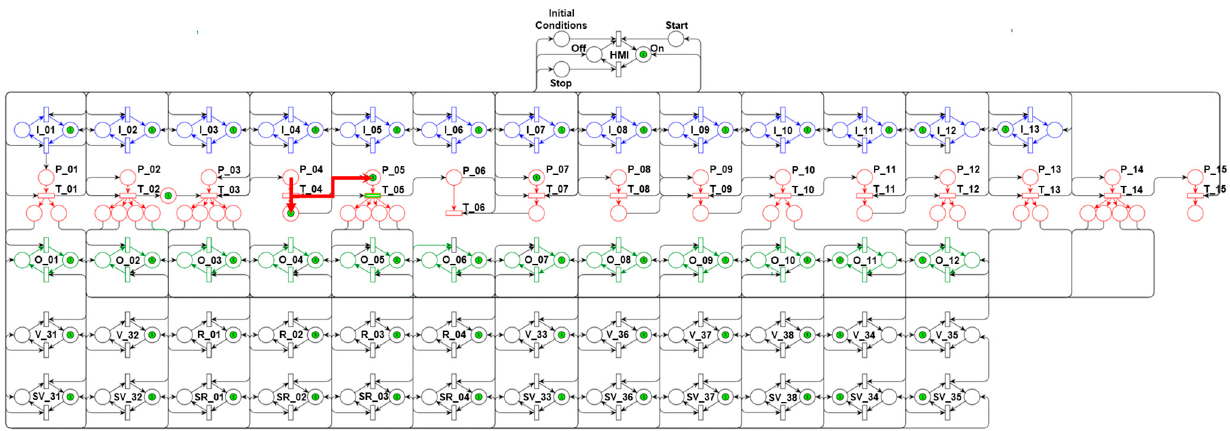
Figure 16. Algorithm’s fifth step—Timer.